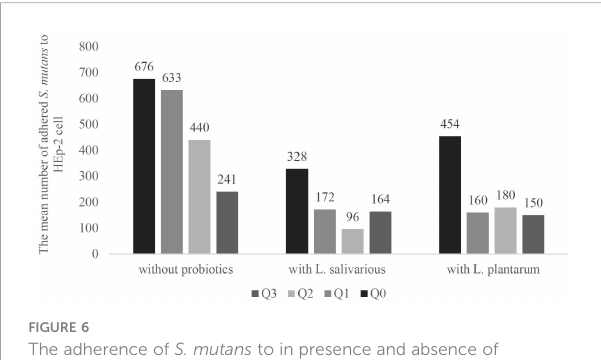
FIGURE 6 The adherence of S. mutans to in presence and absence of probiotics and Q10. S. mutants adhesion is an important step in the pathophysiology of various diseases, and higher adherence may lead to lower viability of HEp-2 cells and other dental complications. The adherence was measured using a microscope and observing 100 Hep-2 cells in 5 fi elds. The results indicate the mean number of adhered S. mutans . Q0, absence Q10; Q1, 1 m g Q10; Q2, 5 m g Q10; and Q3, 10 m g Q10.